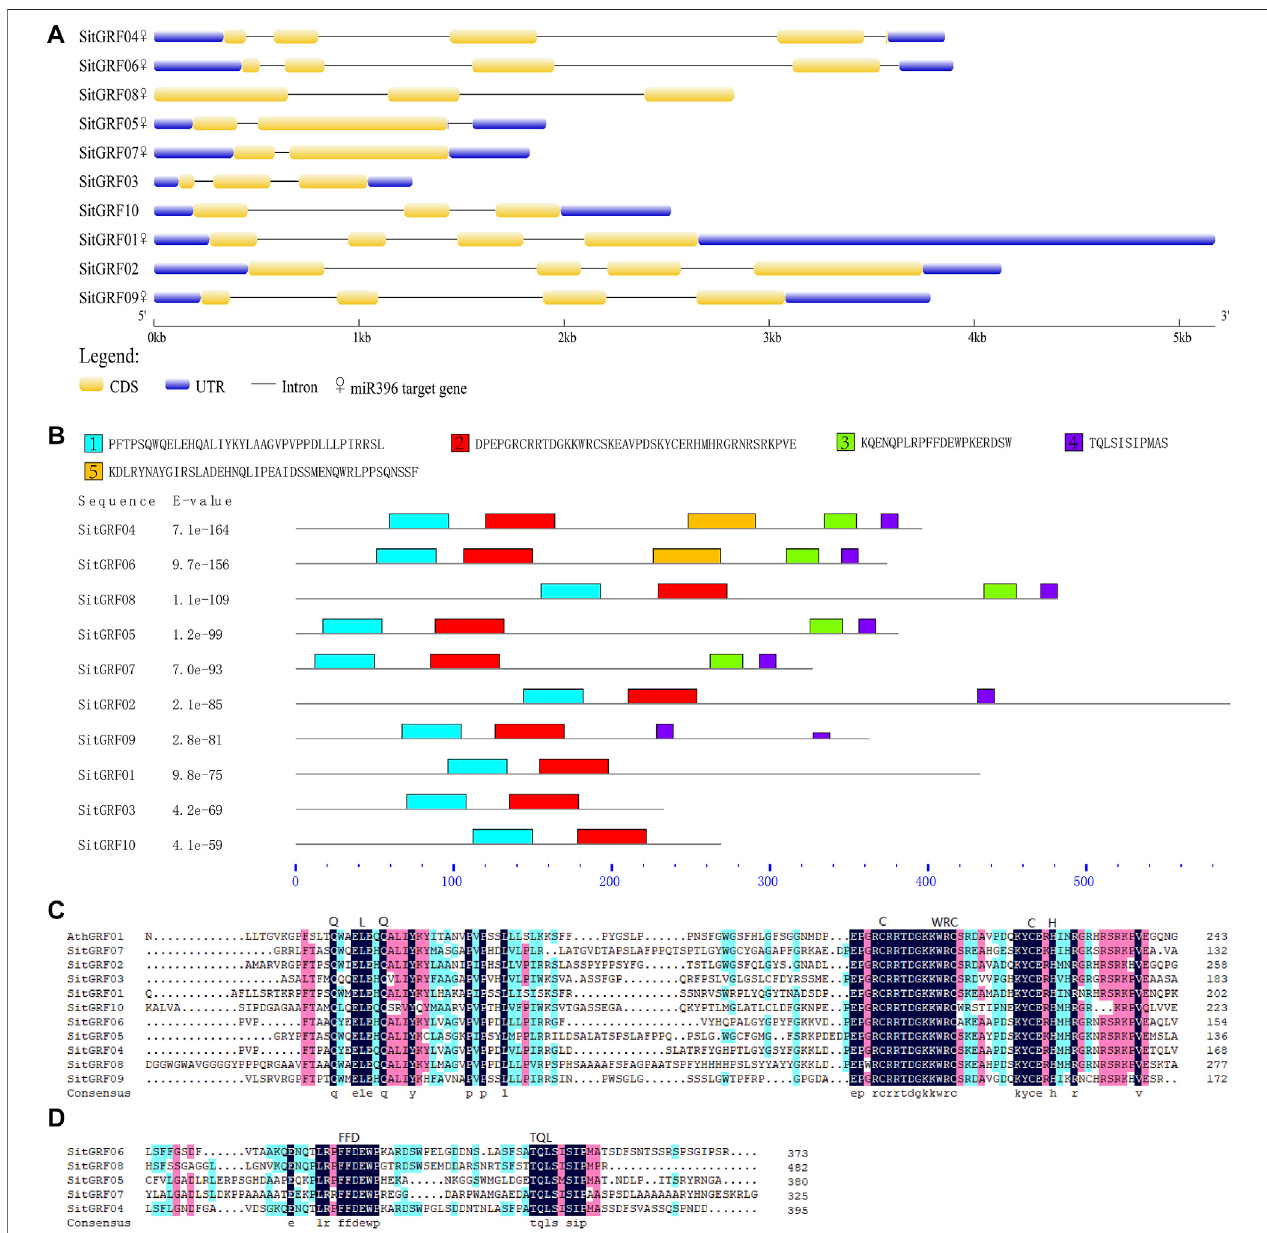
FIGURE 7 | Characterization of foxtail millet GRF s. (A) Exon-intron organization and miR396 binding information of foxtail millet GRF family. (B) Distributions of conserved motifs in foxtail millet GRF genes. Five putative motifs are indicated in different colored boxes. (C) Comparison of the amino acid sequences of foxtail millet GRF QLQ and WRC domains. (D) Multiple sequence alignment of the amino acid sequences of foxtail millet GRF other domains.